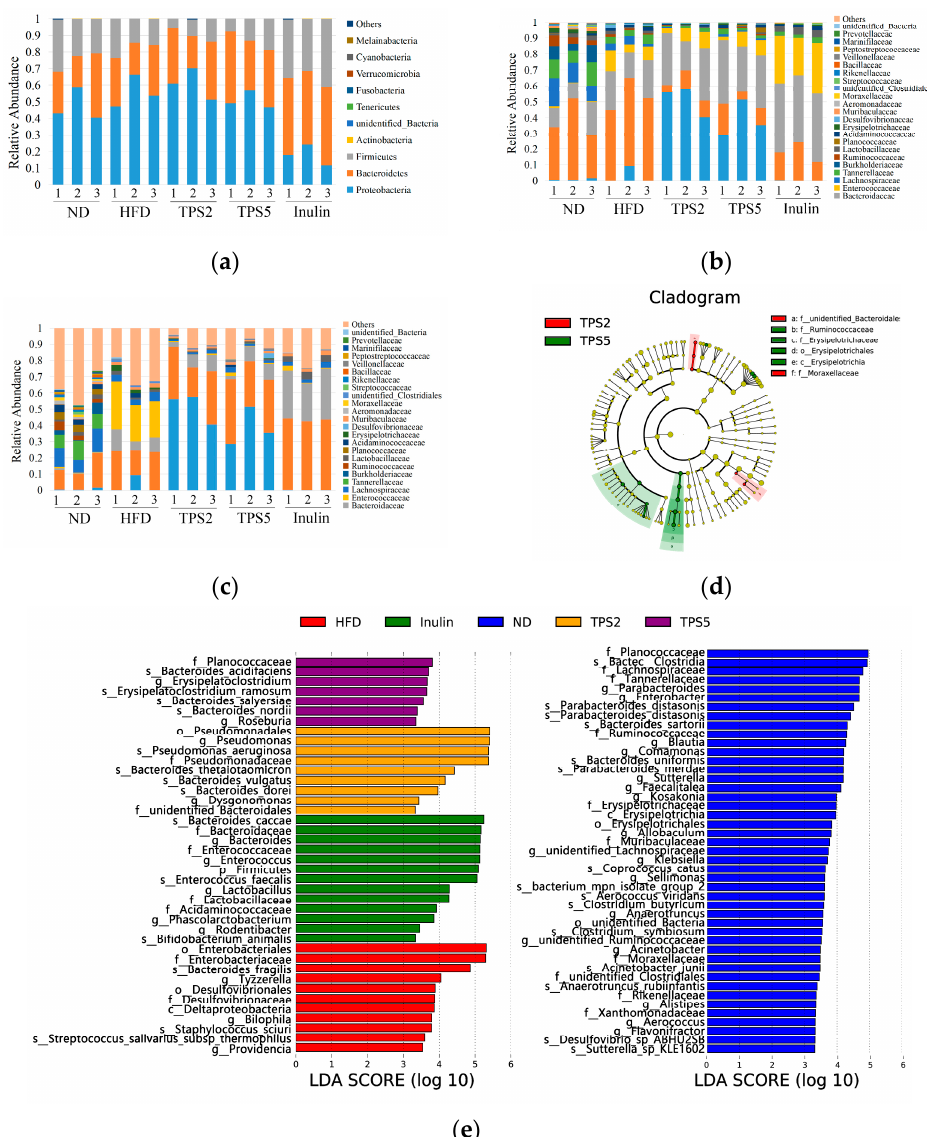
Figure 4. Microbiota composition during in vitro fermentation. Relative abundance of bacterial community at the phylum level ( a ), family level ( b ), and genus level ( c ). Cladogram of LEfSe of 48 h fermentation samples; TPS2 and TPS5 ( d ); ND, HFD, TPS2, TPS5, and inulin ( e ).